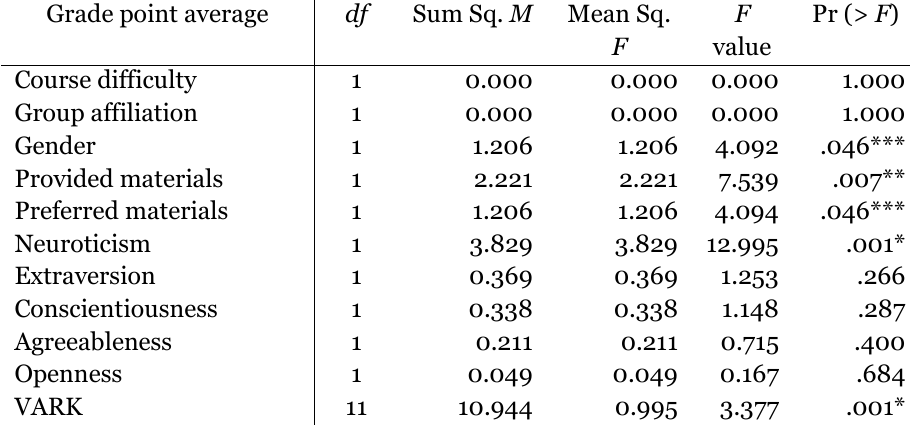
ANOVA Analysis for Overall Academic Success Grade point